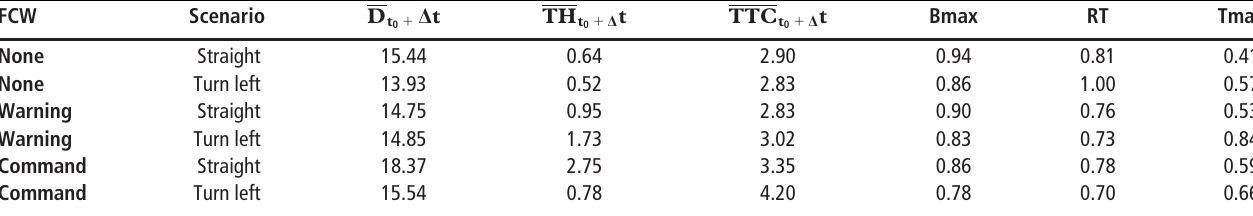
Table 3 Differences of driver ’ s collision avoidance performance under different road environment FCW